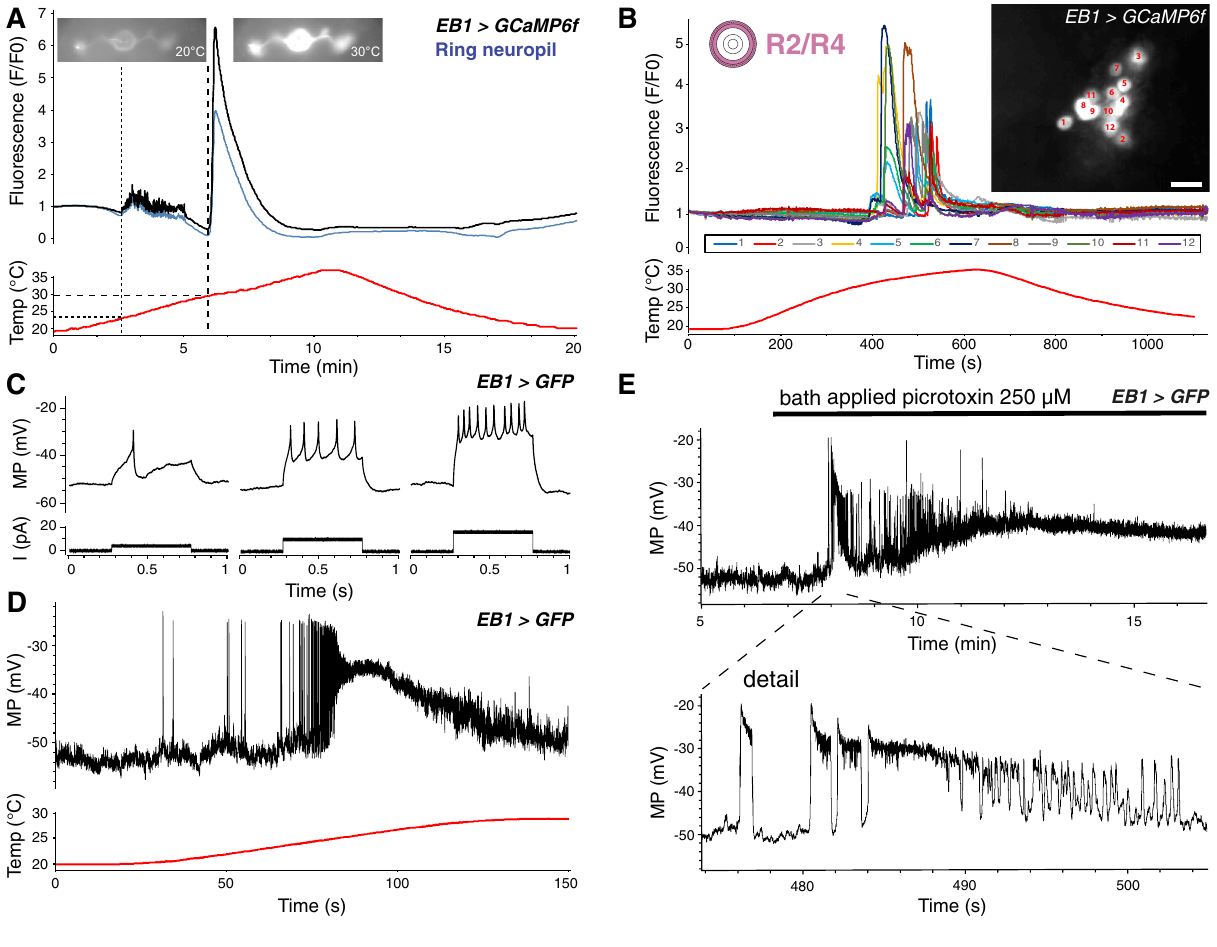
Figure 3. Increasing temperature evokes neural activity in inhibitory GABAergic R2/R4 ring neurons. ( A ) GCaMP imaging of an exemplary EB1-targeted R2/R4 ring neuron during a temperature ramp from 18 °C to 35°. Note that sparse activity starting at 23 °C (tight dashed line) resolves in a Ca 2+ spike around 30 °C (wide dashed line) for both cell bodies (black line) as well as ring neuropil (blue line). ( B ) GCaMP imaging of individual cell bodies (indicated by colours and numbers in insert) of R2/R4 ring neurons during a temperature ramp from 20 to 35 °C show a brief Ca 2+ spike for all cells at high temperature. Scale bar, 10 µm. ( C ) Whole- cell recordings of EB1 > mCD8::GFP R2/R4 neurons. Injection of increasing amounts of depolarising current (I) evokes repetitive firing, with spike frequency increase proportional to stimulus strength. ( D ) Temperature increase from 20 °C to 30 °C elicits an increase in activity of an EB1-targeted R2/R4 ring neuron up to depolarising block before hyperpolarisation towards rest. ( E ) Spiking and bursting activity of an EB1-targeted R2/R4 ring neuron after application of 250 µM picrotoxin. MP, membrane potential; I, current. See also Supplementary Fig. S3 and Supplementary Video